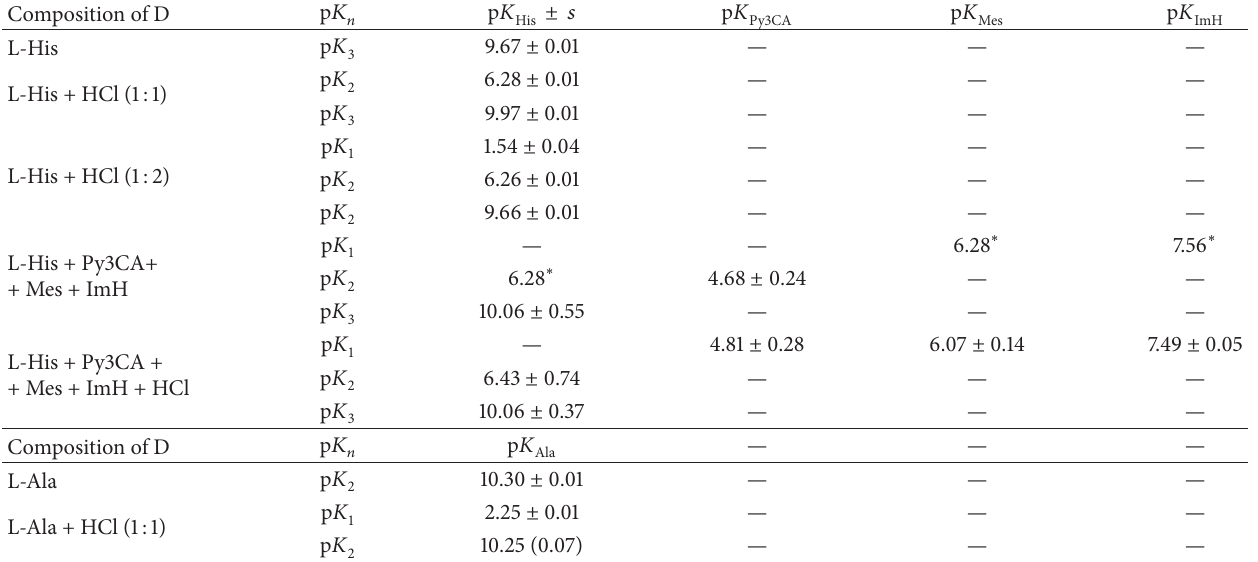
Table 7: The p 𝐾 ’s values of compounds determined in the multicomponent mixture of amino acid, heterocyclic moiety, and weak (Mes) a and strong (HCl) acids at 25 ∘